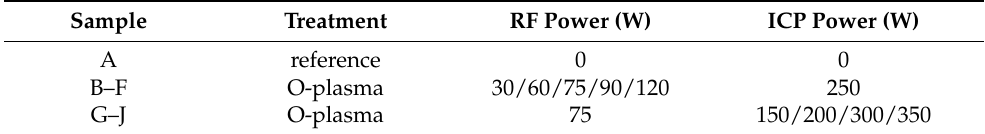
Table 1. Treatment conditions of all